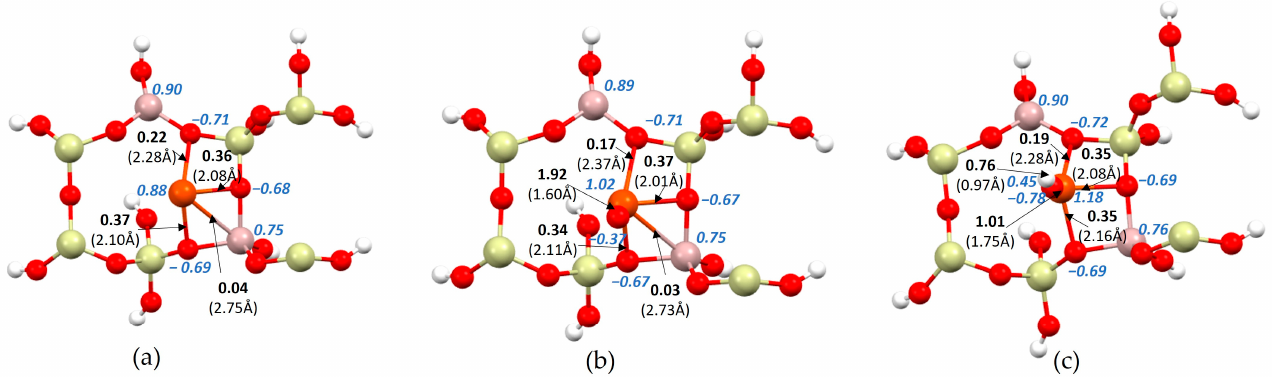
Figure 2. Fragment of structures with active iron adsorbates inside the pore: ( a ) ZSM-5 with iron, ( b ) ZSM-5 with iron oxide, and ( c ) ZSM-5 with iron hydroxide. Italic blue—ionicity, bold—bond order, bracket—bond length.